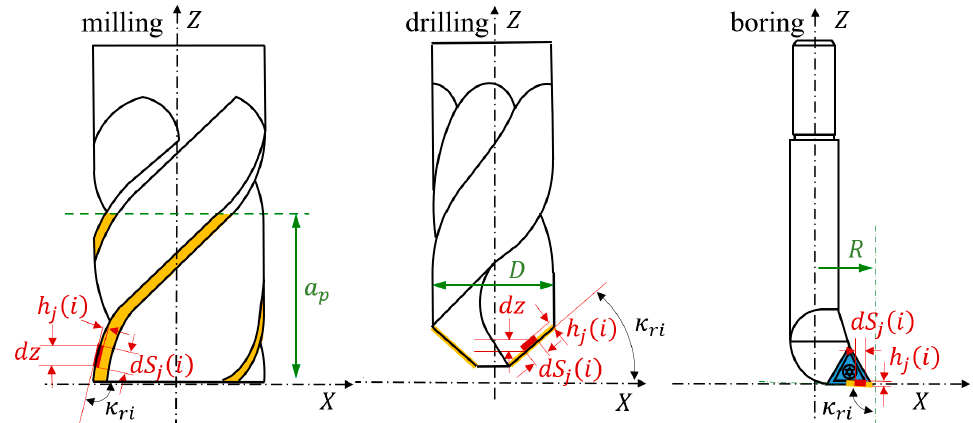
Figure 2. Segment of insert in different basic machining operations. In Figure 2, a p is the depth of cut, D is the cutter diameter, R is the radius of